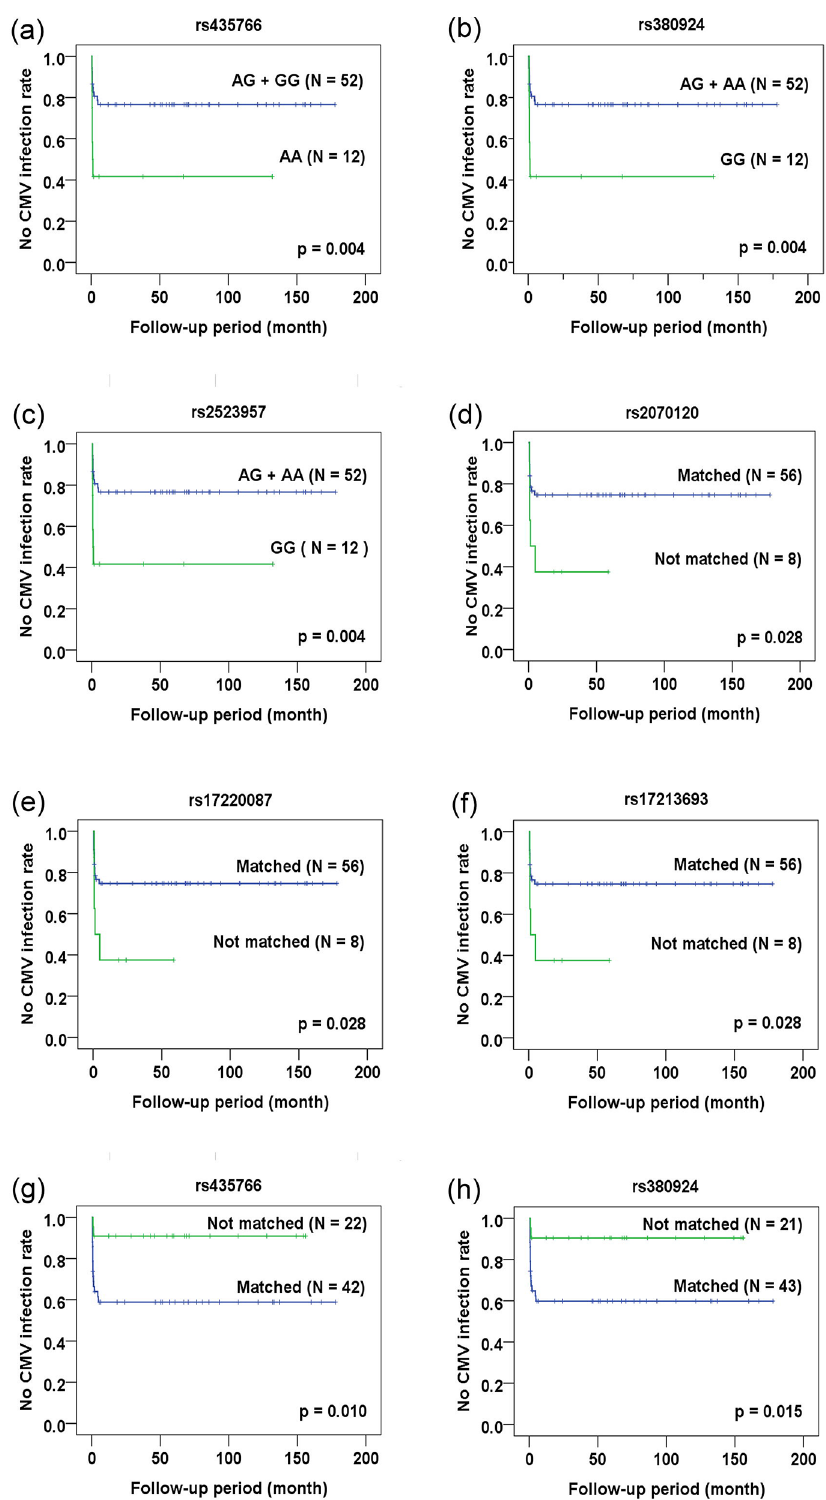
Figure 1. Kaplan–Meier analysis of CMV infection/reactivation-free duration. ( a – h ) CMV-related SNPs as revealed by end-point analysis were subject to Kaplan–Meier analysis. The CMV infection/reactivation-free status for recipients with the indicated genotype (panels a – c ) or matched vs. not matched status for the donor and recipient genotype (panels d – h ) was plotted against the follow-up period (month) after